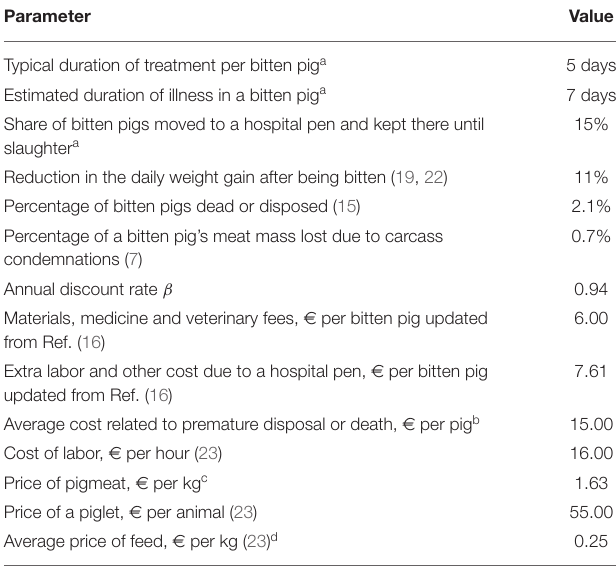
TABLE 1 | Parameter values used in the model to simulate the economic consequences of tail biting in a